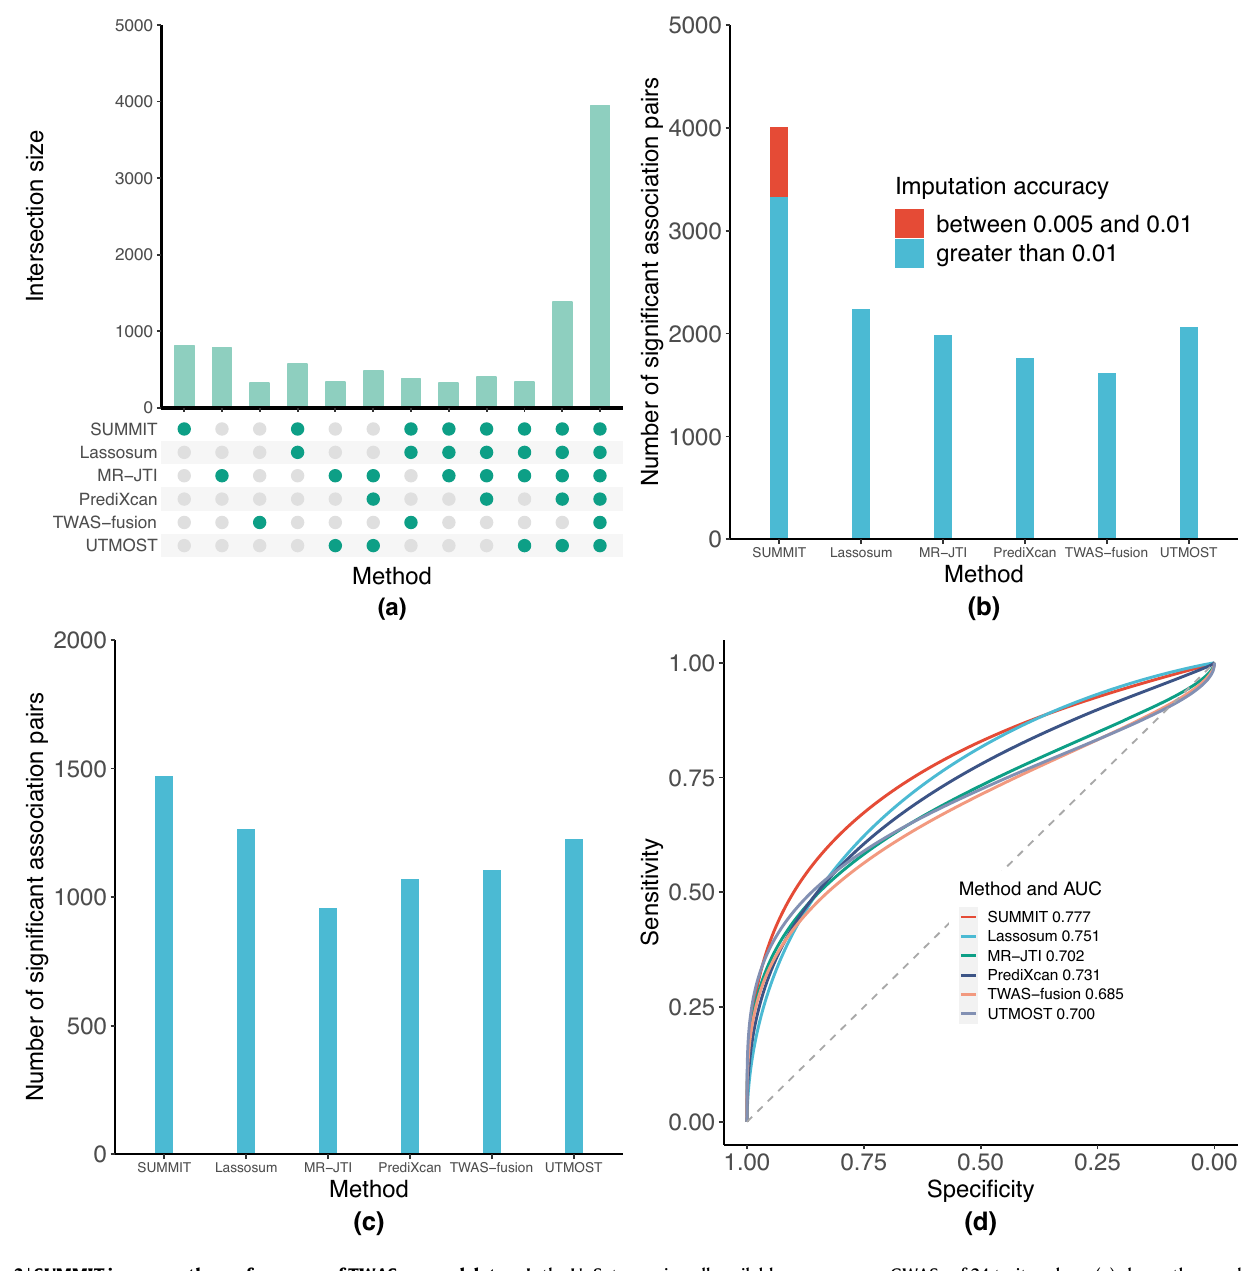
using all available genes across GWASs of 24 traits, where ( c ) shows the number of associated genes when evaluating a common gene set ofall methods. d Is the ROC plot for identifying “ silver standard ”